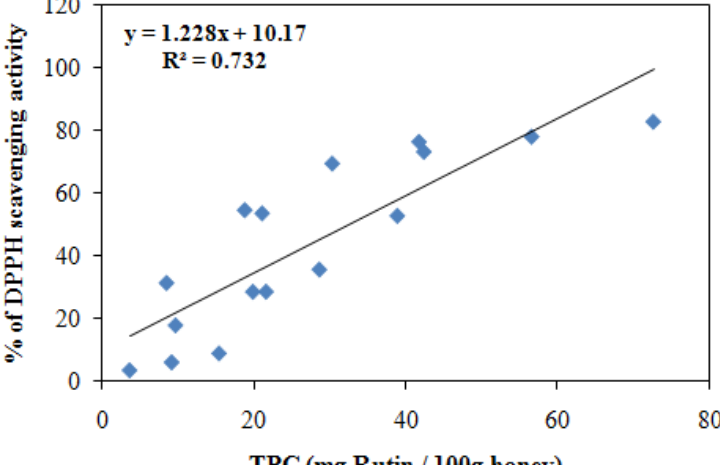
Figure 2. Correlation between the radical scavenging activity (% inhibition) using DPPH of combined (Gelam and Nenas) honey and total phenolic contents (TPC) to obtain the r =